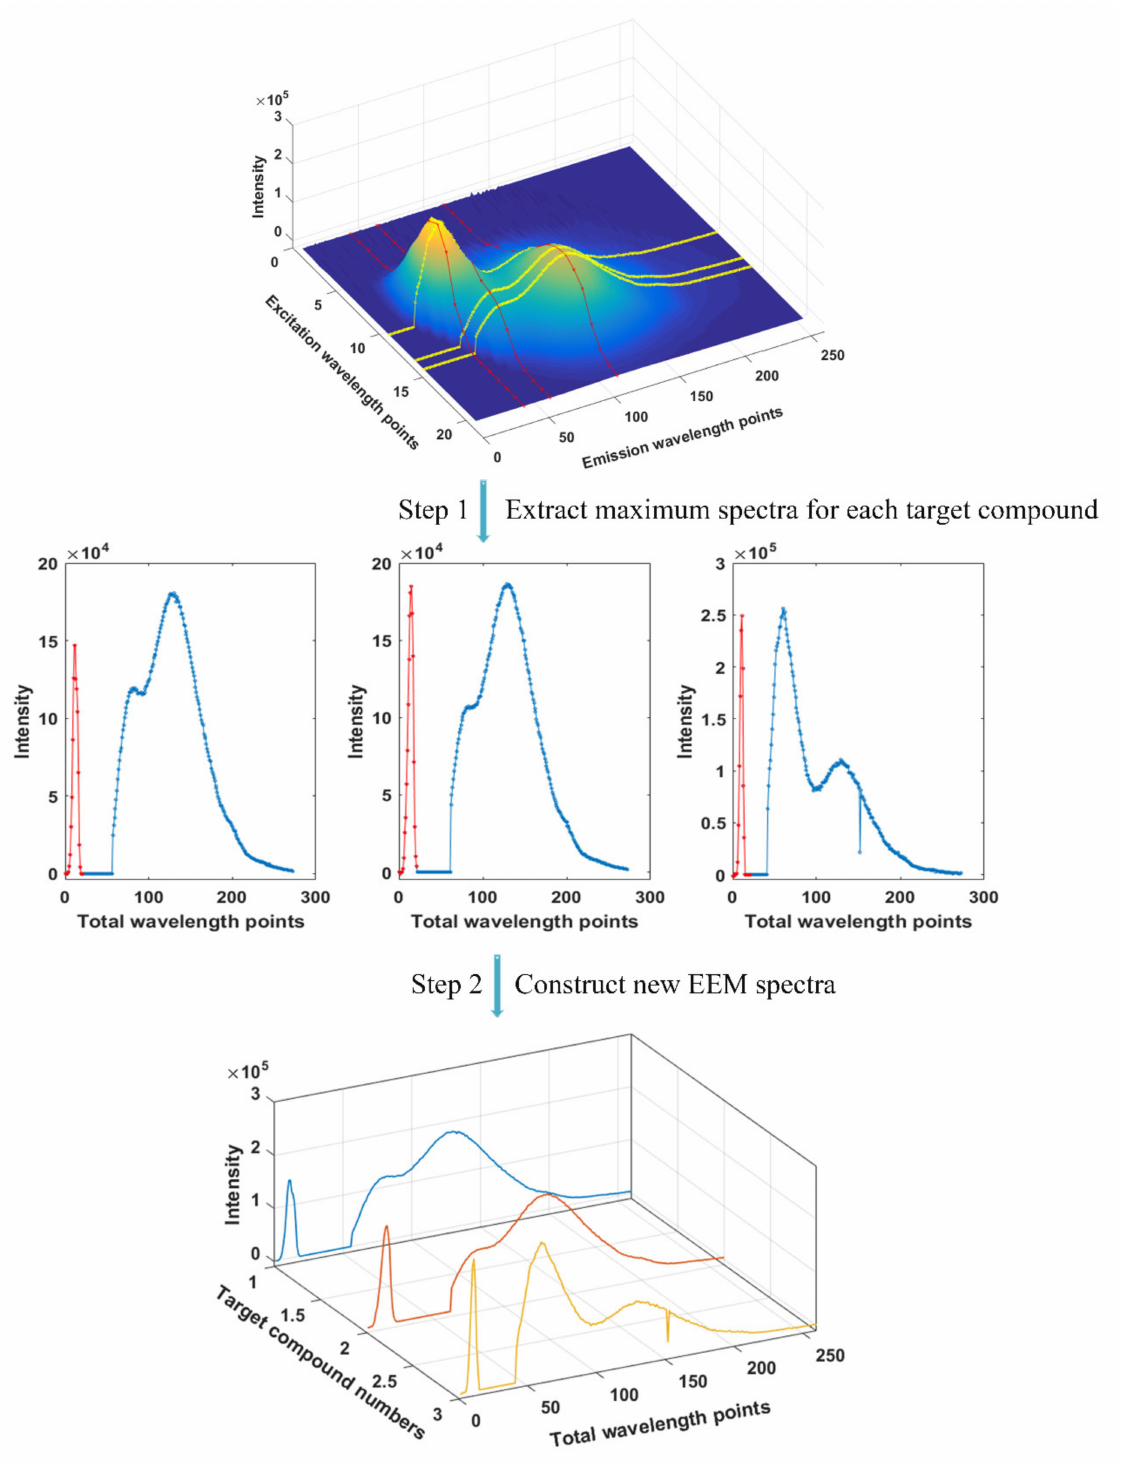
Figure 4. The overall strategy for the construction of the new constructed 3D EEM